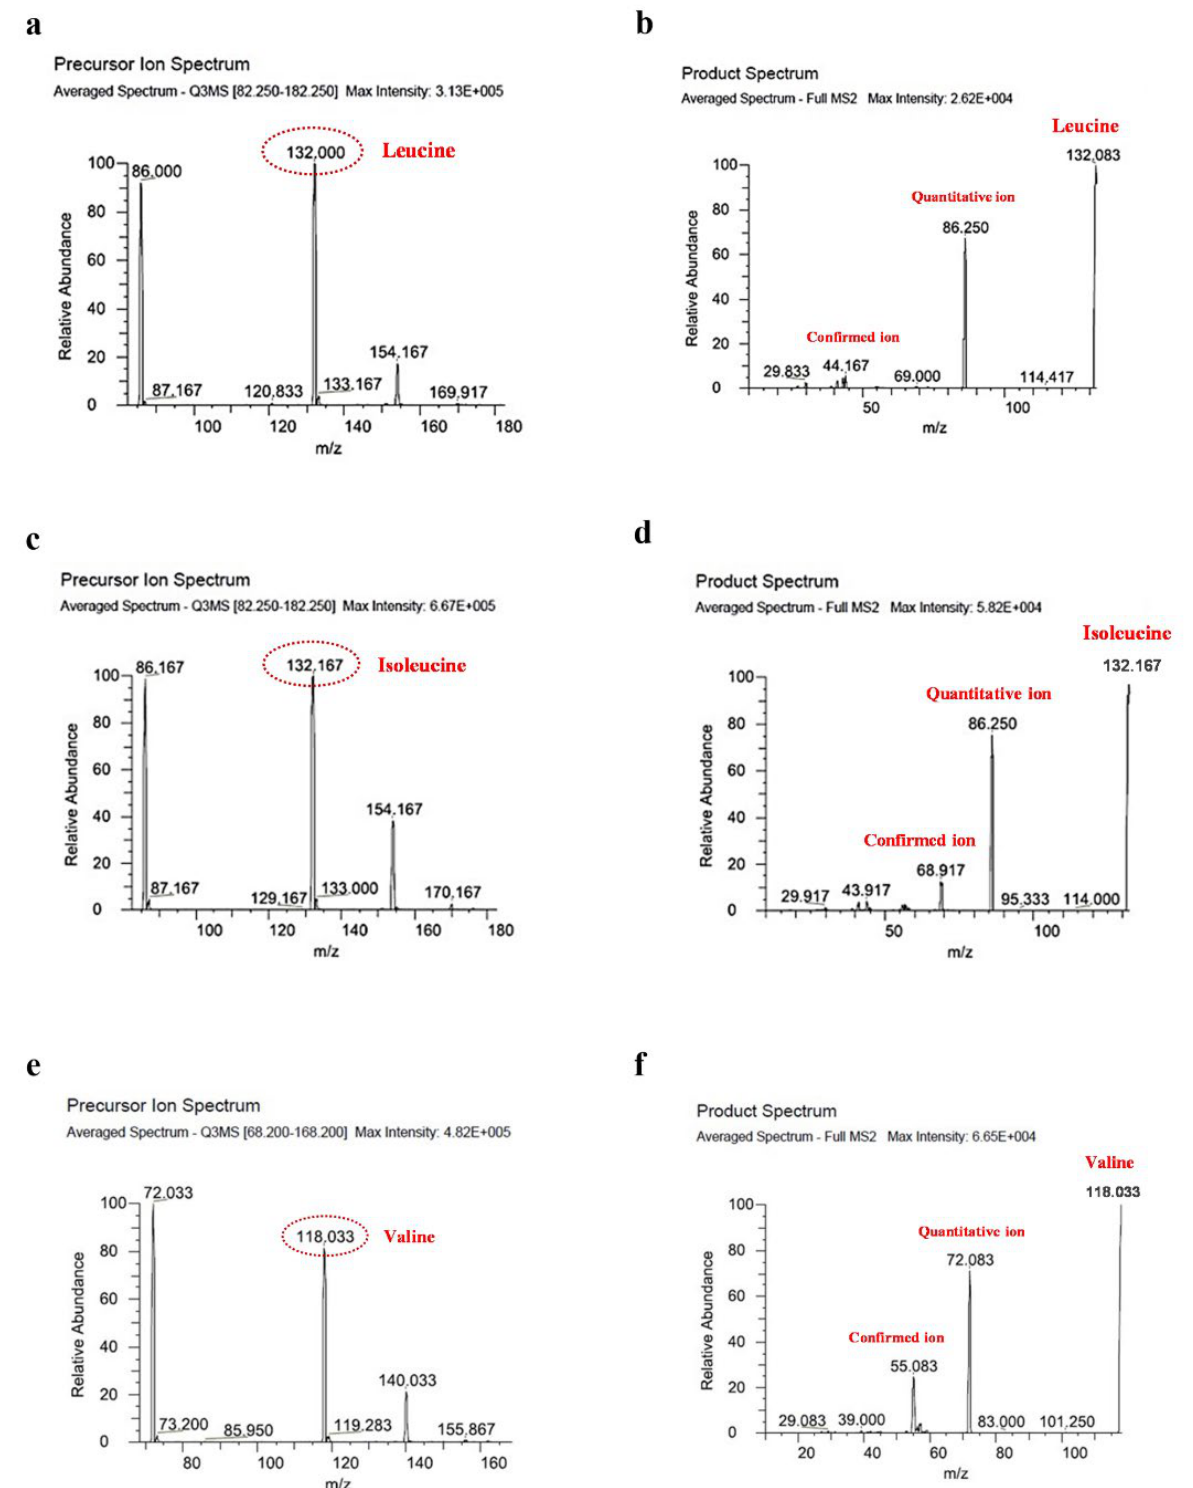
Figure 2. Mass spectra of the precursor and product ion masses of branch-chain amino acids (leucine, isoleucine, and valine), scanned by LC-MS/MS. Precursor ion and product ion spectrums of leucine ( a , b ), isoleucine ( c , d ), and valine ( e , f ), respectively. The number in the oval represents the mass per charge ( m / z ) ratio of the precursor. The m/z values for quantitative and confirmed product ions for each amino acid are labeled.